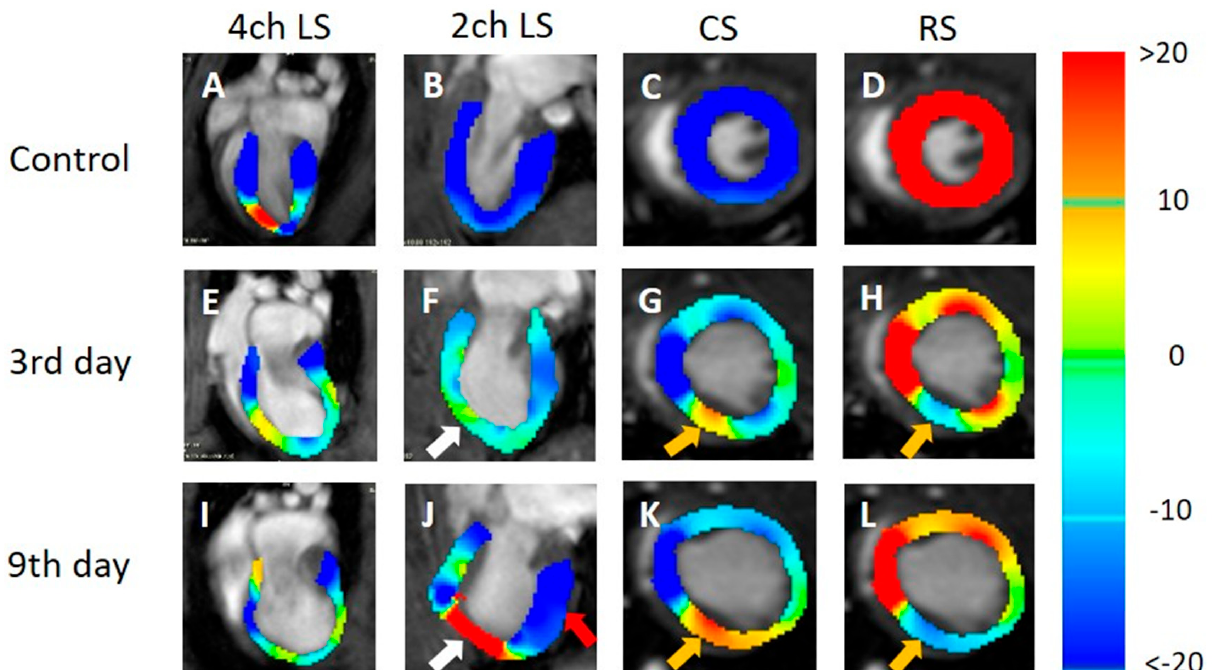
Figure 6. Strain-encoded functional magnetic resonance imaging of the end-systolic left ventricle. 4ch LS, four-chamber view longitudinal strain; 2ch LS, two-chamber view longitudinal strain; CS, short-axis view circumferential strain; RS, short-axis view radial strain. ( A , E , I ) LS in the long-axis four-chamber view. ( B , F , J ) LS in the long-axis two-chamber view. ( C , G , K ) CS in the short-axis view. ( D , H , L ) RS in the short-axis view. ( A , B , C , E ) Control, ( E , F , G , H ) 3 days after the onset of myocardial infarction, and ( I , J , K , L ) 9 days after the onset of myocardial infarction. The color bar shows the scale of the strain based on the end-diastolic left ventricle, with maximum contraction shown in red and minimum contraction in blue. White arrows: infarcted area. Red arrow: contracting area. Yellow arrows: reduced functionality.